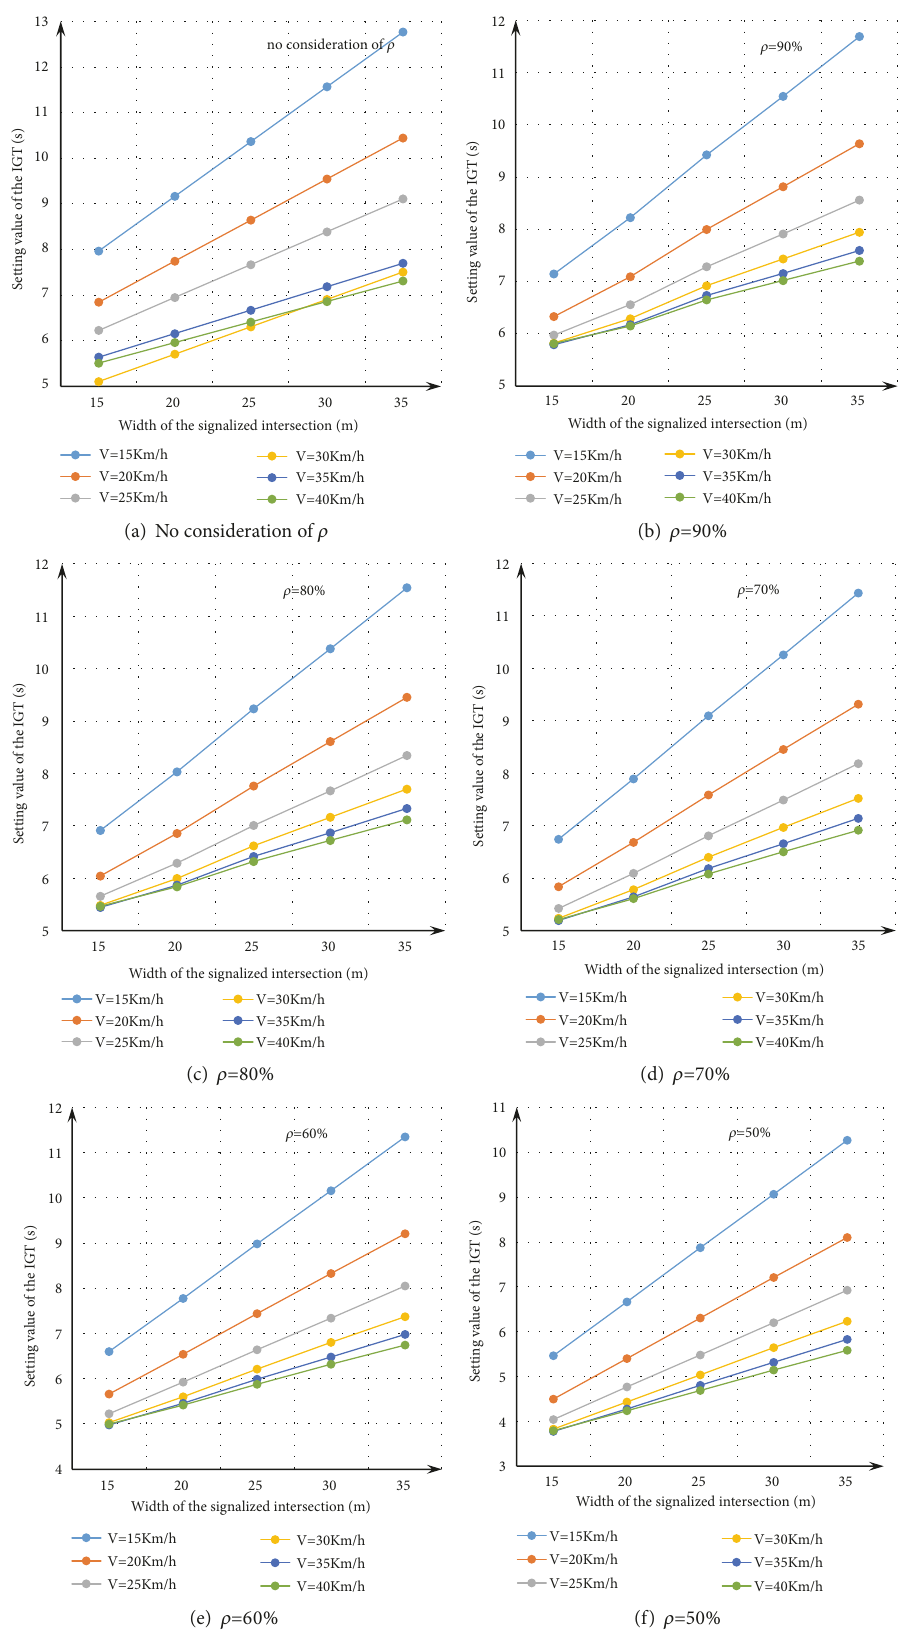
Figure 6: The curve family of IGT and safety reliability at signalized